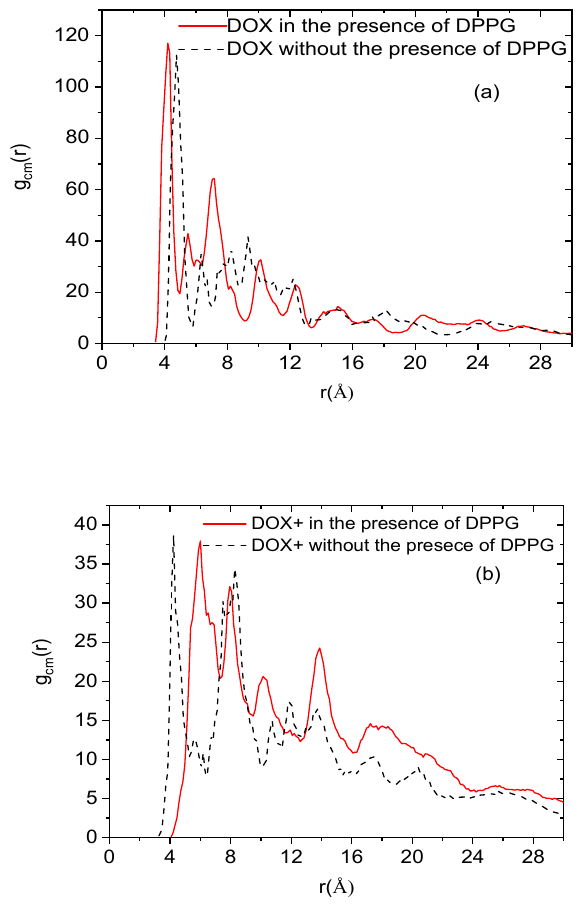
Figure 8. Radial distribution functions of the center of mass of the doxorubicin molecules in the presence (solid lines) and in the absence (dashed lines) of the bilipid membrane, for the ( a ) neutral and the ( b ) protonated drug molecules.